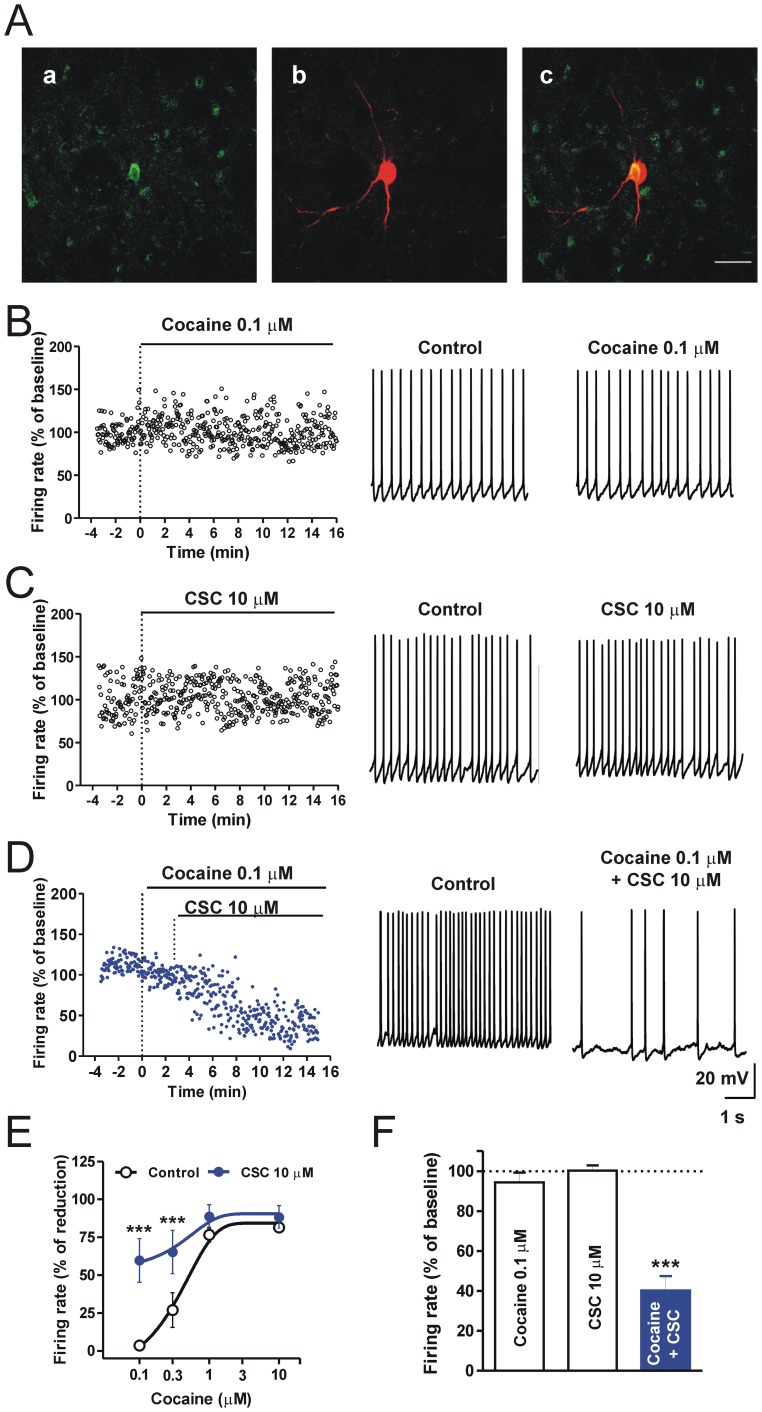
Cocaine and 8-(3-Chlorostyryl)-caffeine co-application reduce the firing discharge rate of striatal cholinergic interneurons.(A) Representative confocal laser scanning microscopy images of striatal cholinergic interneurons filled with biocytin during electrophysiological recordings. Double immunofluorescence detection of biocytin and anti-choline acetyl transferase (ChAT). Biocytin is visualized in green-cy2 fluorescence (a), ChAT in red-cy3 fluorescence (b). Left panel is the merged image (c) Scale bar: 50 µm. (B) Representative time-course of the firing rate and example of trace recordings from cholinergic interneurons in control conditions and in the presence of 0.1 µM cocaine (B), 10 µM CSC (C) or cocaine plus CSC (D), respectively. Plotted mean frequency of the firing activity is calculated in time windows of 5 seconds. (E) Dose-response curves of spike frequency from cholinergic interneurons measured in the presence of cocaine or cocaine plus CSC (cocaine, vs cocaine plus CSC, F(3,28) = 6.5, P<0.01). (F) Histogram of averaged firing frequency of cholinergic interneurons recorded in the presence of cocaine, CSC and cocaine plus CSC, cocaine vs cocaine plus CSC, Bonferroni’s post-hoc test, ***P<0.001.